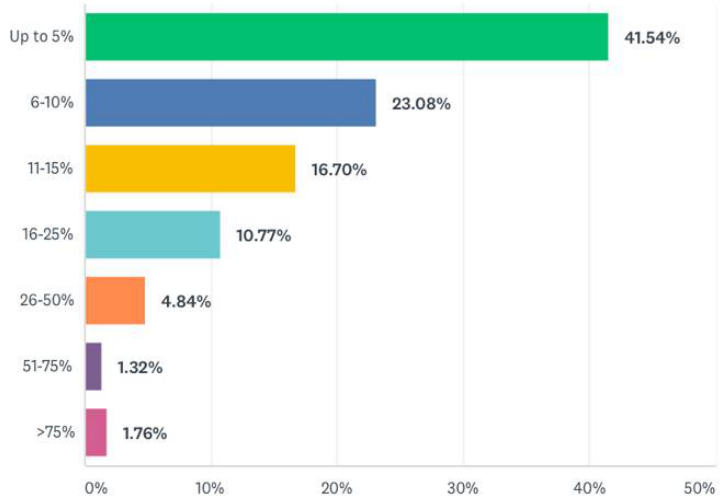
Figure 5. Amount U.S. participants are willing to pay—experiences that are respectful of Hawaiian